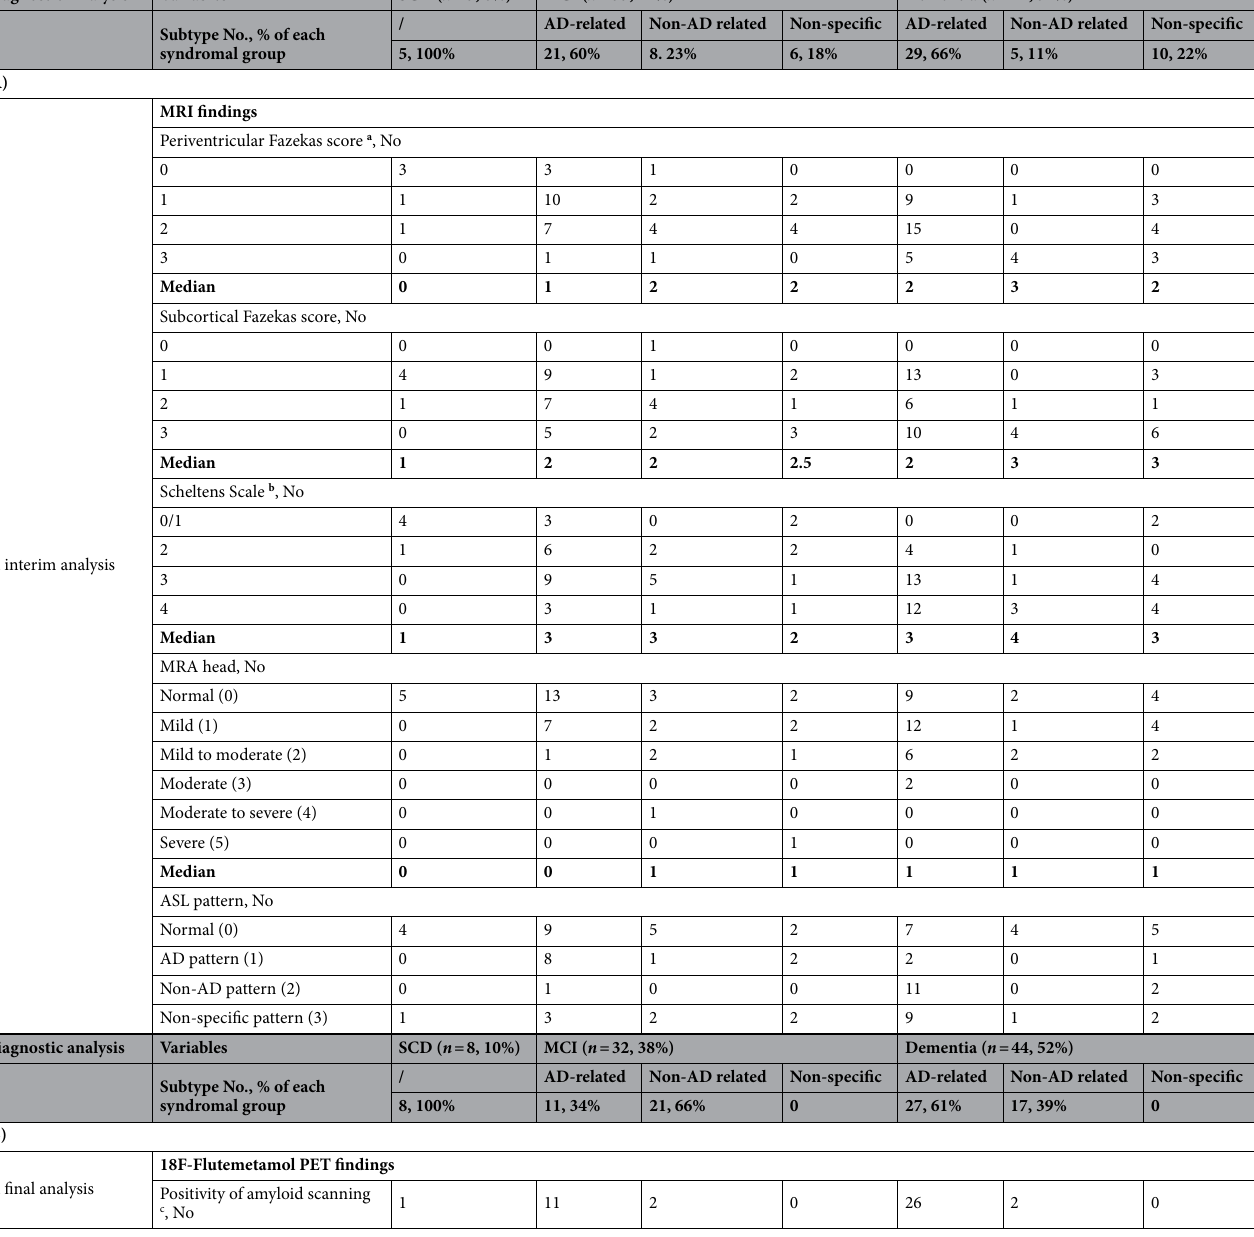
Table 4. Diagnostic results and post-neuroimaging findings. (A) post-MRI, (B) post-18F-Flutemetamol PET. a periventricular Fazekas score: SCD vs. non-AD related dementia, p < 0.05. b Scheltens scale: SCD